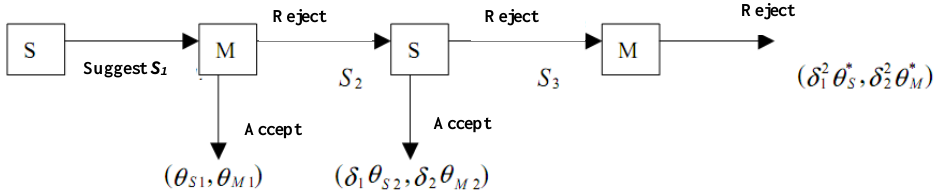
Figure 5. Three-stage bargaining model [37].